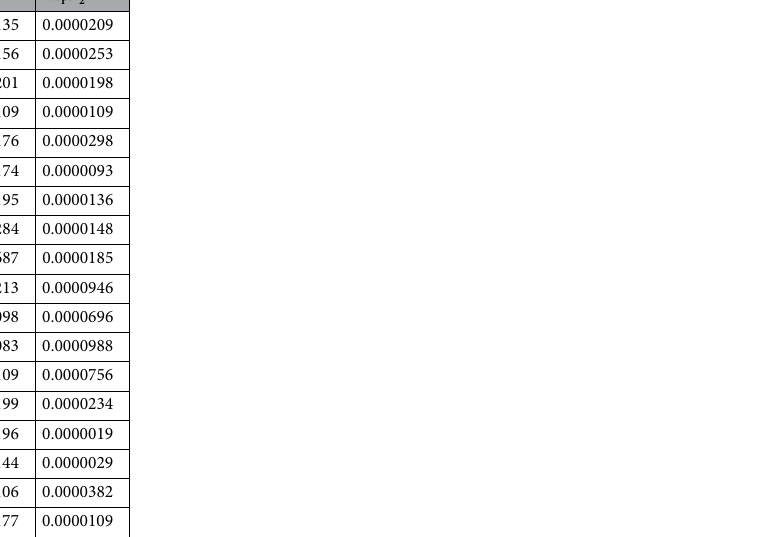
Table 11. Margin of error.